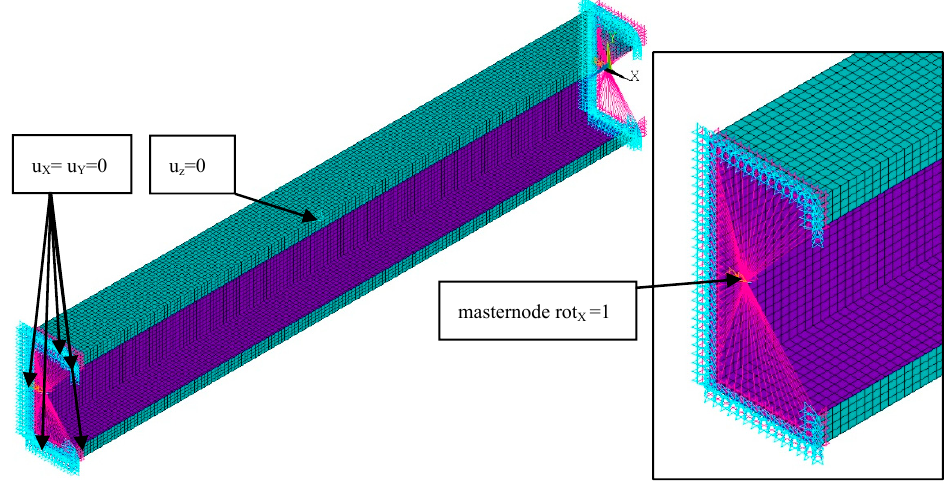
Figure 2. Discretized numerical model with applied type II boundary conditions.